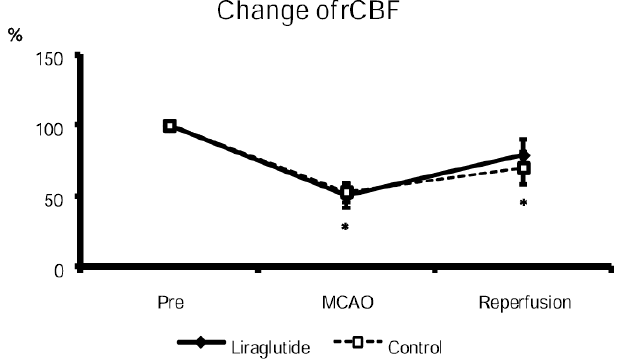
Figure 2. Reduced and partially recovered cortical blood flow at MCAO and